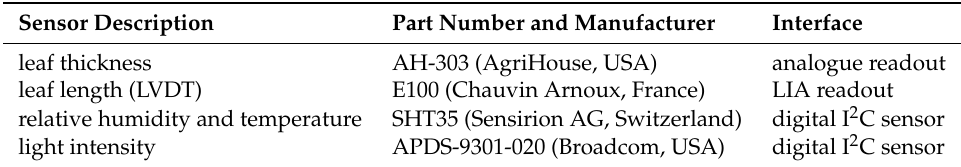
Table 3. Overview of the different sensors used in the experimental validation of the